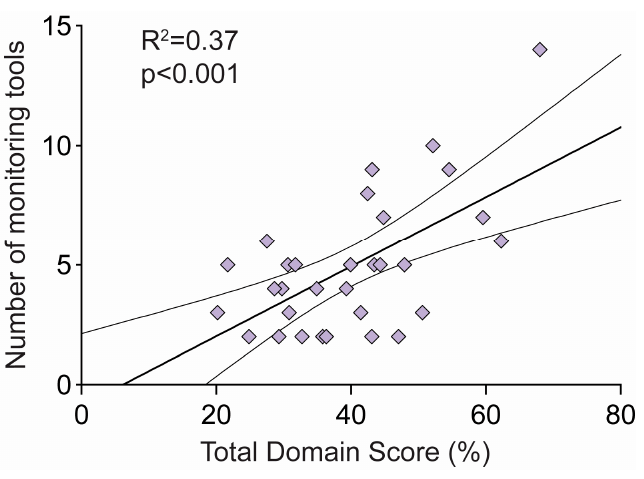
Figure 3. Linear regression between total domain score and the number of monitoring tools for all 31 apps.